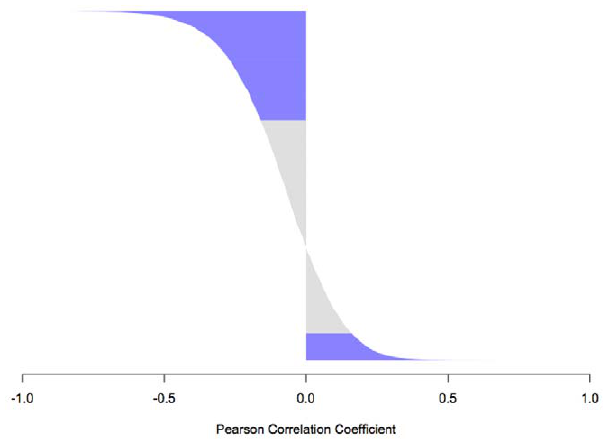
Figure 5. Analysis of correlation between methylation level and gene expression in 57 breast tumor samples. Pearson correlation values between methylation level and mRNA expression level are shown on the x-axis, with negative values representing inverse correlations and positive values representing positive correlations. Significant correlations (P , 0.004, FDR , 0.01) are indicated in blue.